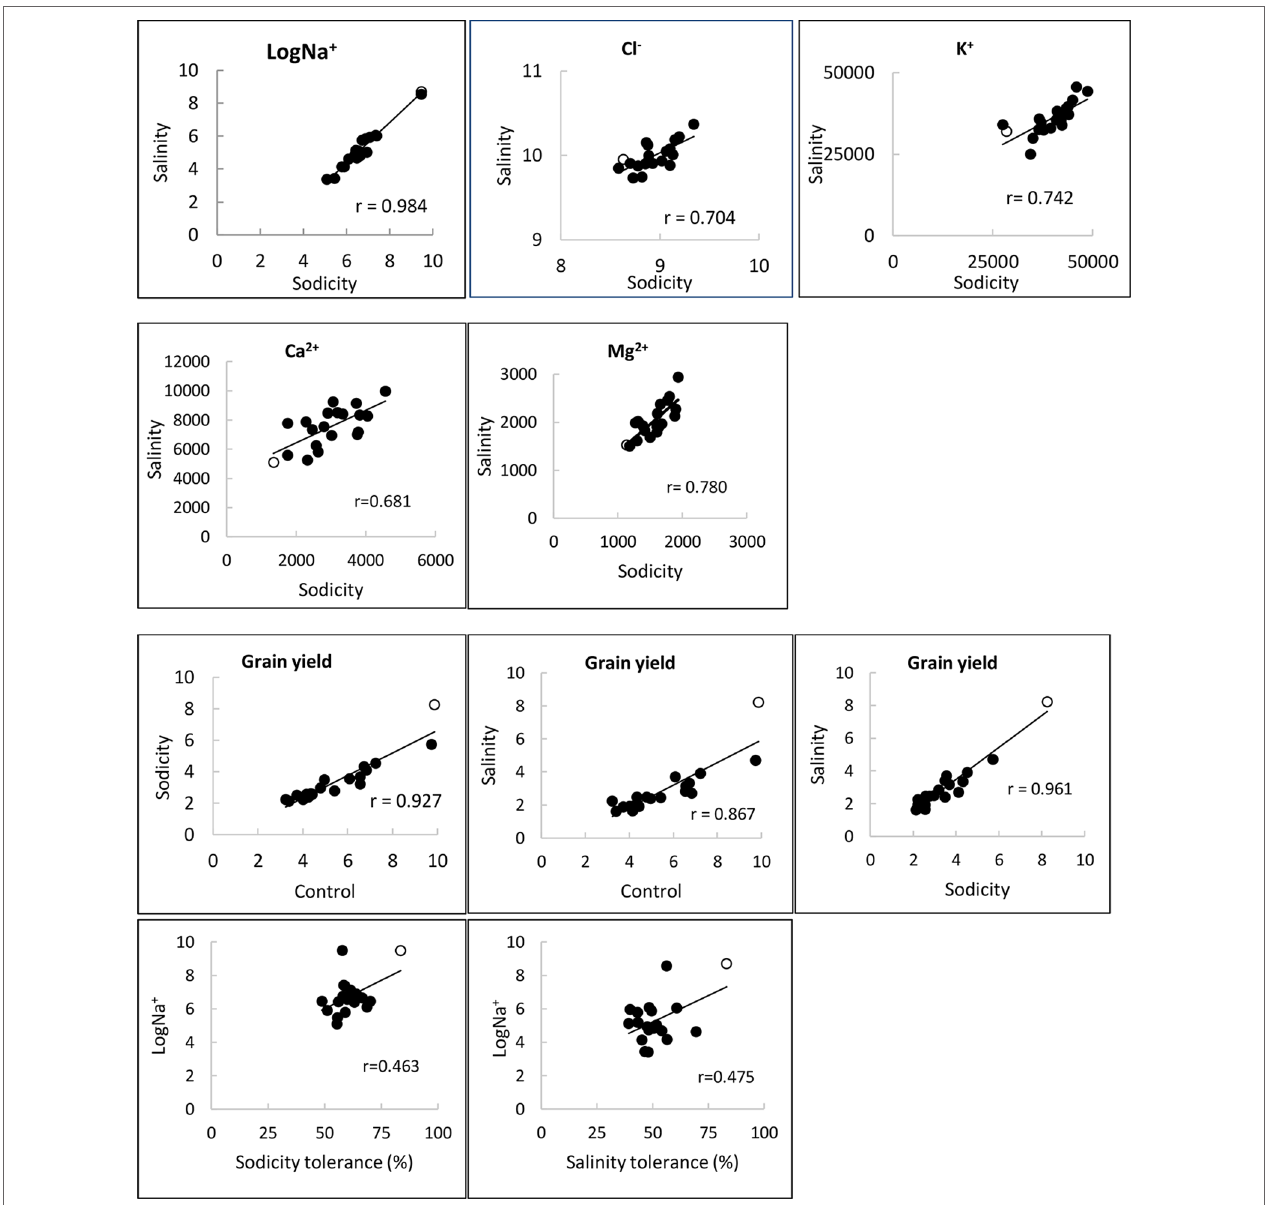
FIGURE 4 | Relationships of Na + , Cl - , K + , Ca 2+ and Ma 2+ concentrations (mg kg -1 DW), and grain yield (g plant -1 ) under control, salinity (100 mM NaCl) and sodicity (8 g kg -1 Na + -humate) in 20 bread wheat entries in Experiment 3 (n = 4) (r = 0.561, df = 18, P < 0.01). MW#293 is shown as an empty